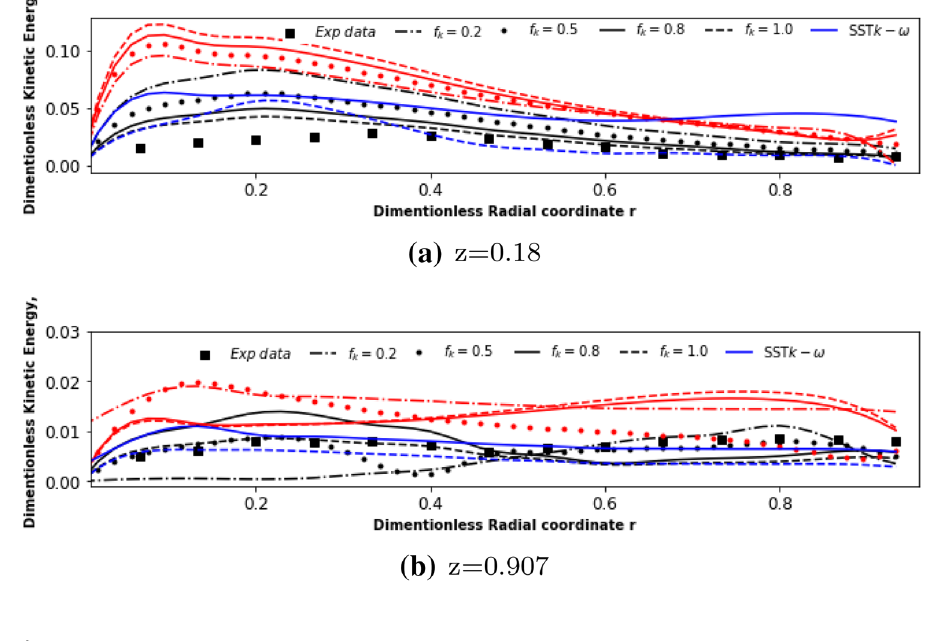
Fig. 6 Radial velocity profiles bellow the impeller at different z-location for f k = 0.2 ( - -- ), = 0.5 ( - - - ), f f k = 1.0 ( - - - ) of PANS k f k